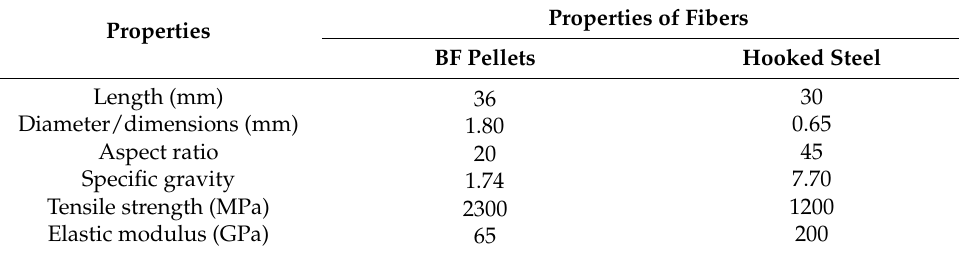
Figure 1. Reinforcing fibers: ( a ) basalt fiber pellets, and ( b ) steel fibers. Table 2. Properties of